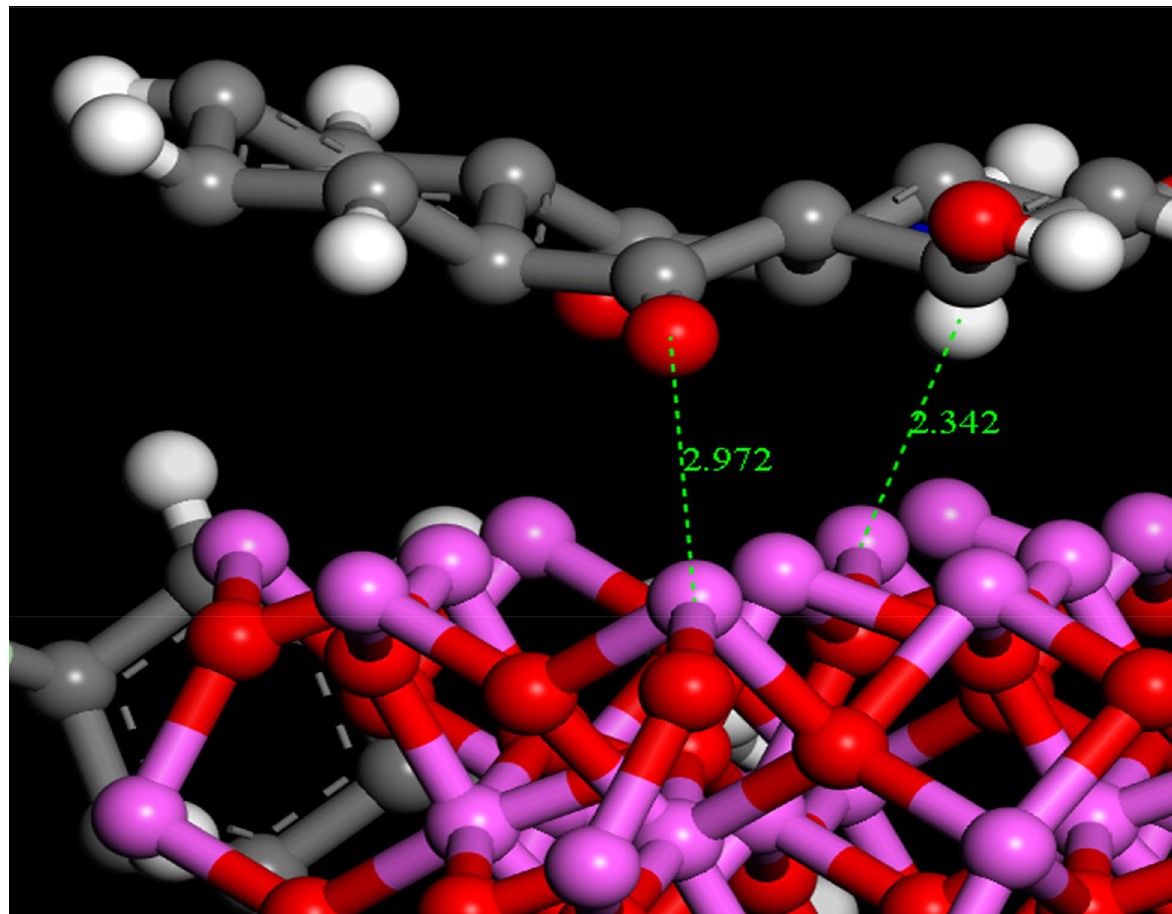
Figure 16. Snapshots for the adsorption configurations of DR adsorbed on CA-1 nm, the bond length is in Angstroms.